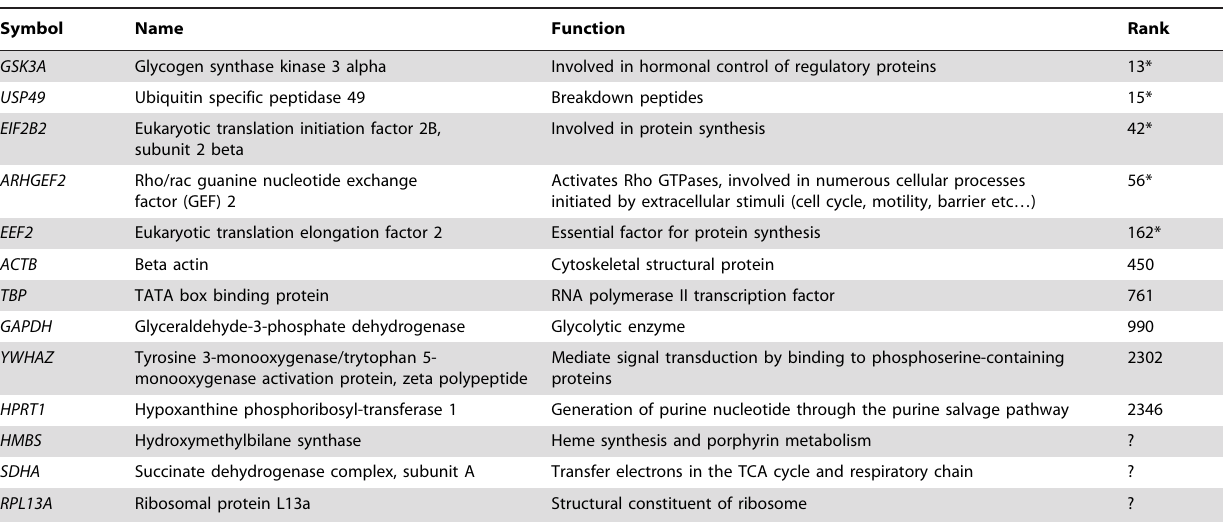
Table 1. List of candidate